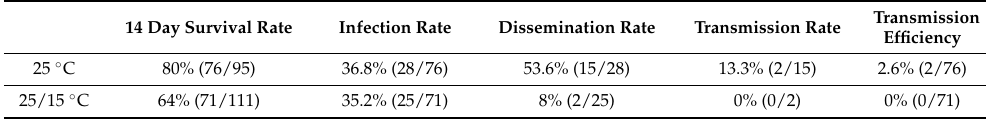
Table 1. Vector competence of Culex pipiens for JEV at two temperature conditions. Results are based on RT-qPCR analyses. Rates are mentioned in percentages and absolute numbers are mentioned between